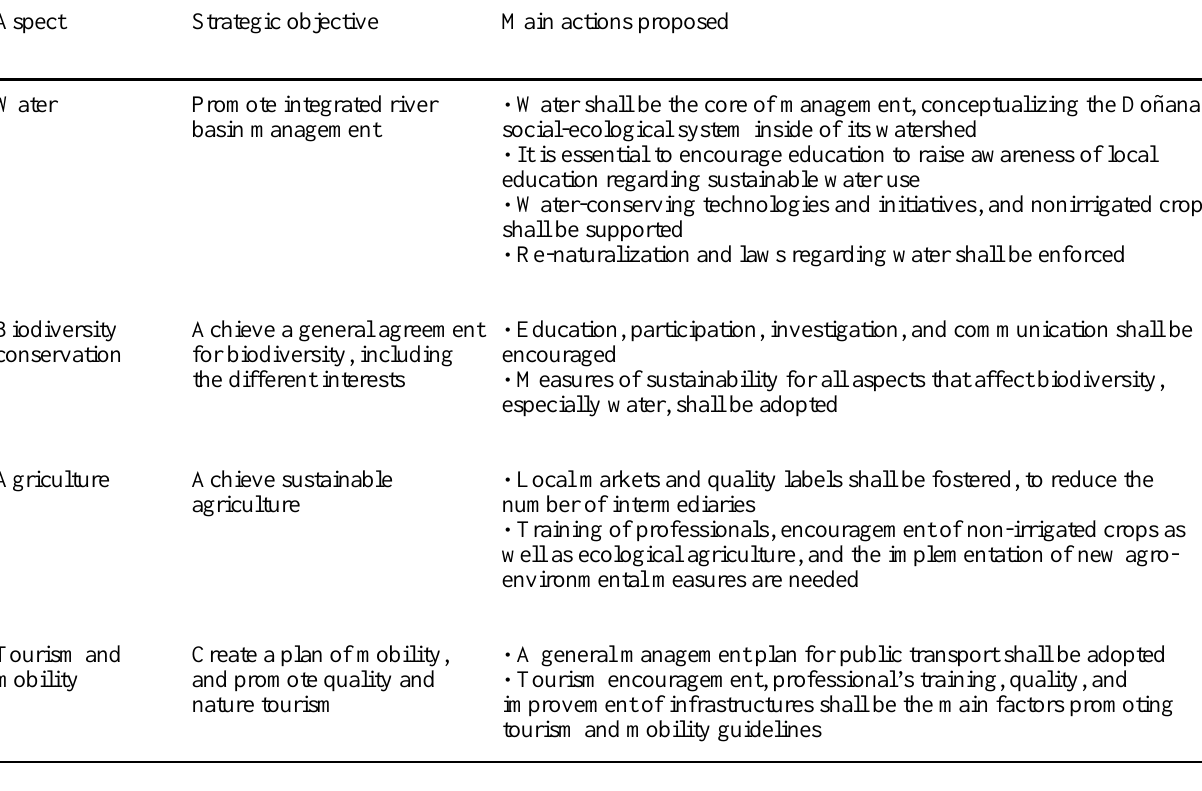
Table 3 . Strategic objectives and main management actions proposed for the Doñana social-ecological system, regarding the four aspects tackled through the backcasting